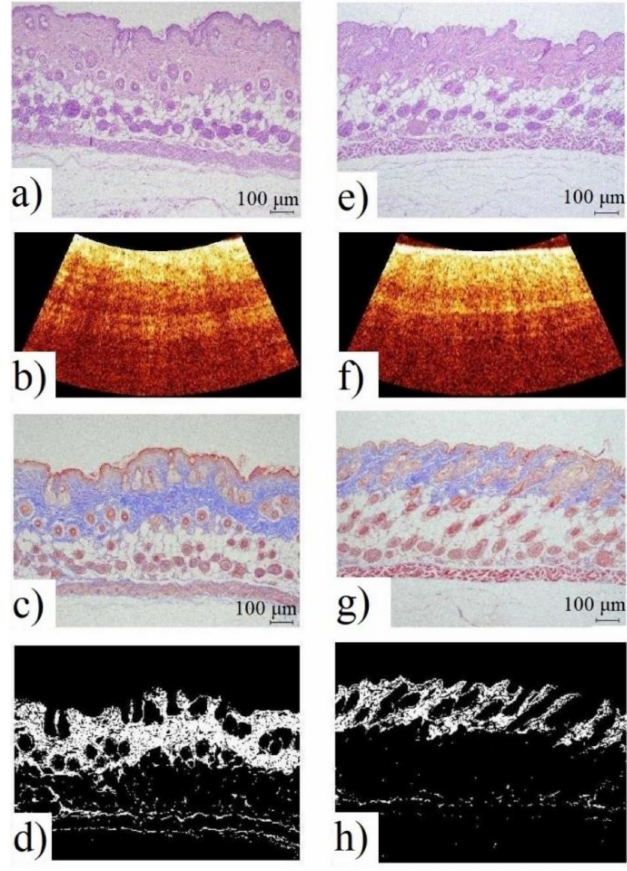
Figure 4. Images of the skin of mice from the “control” ( left ) and “photoaging” ( right ) groups 5 weeks after the start of UV irradiation: histology with hematoxylin/eosin staining ( a , e ); OCT ( b , f ); histology with Masson’s trichrome staining ( c , g ); the result of color threshold filtering of images ( d , h